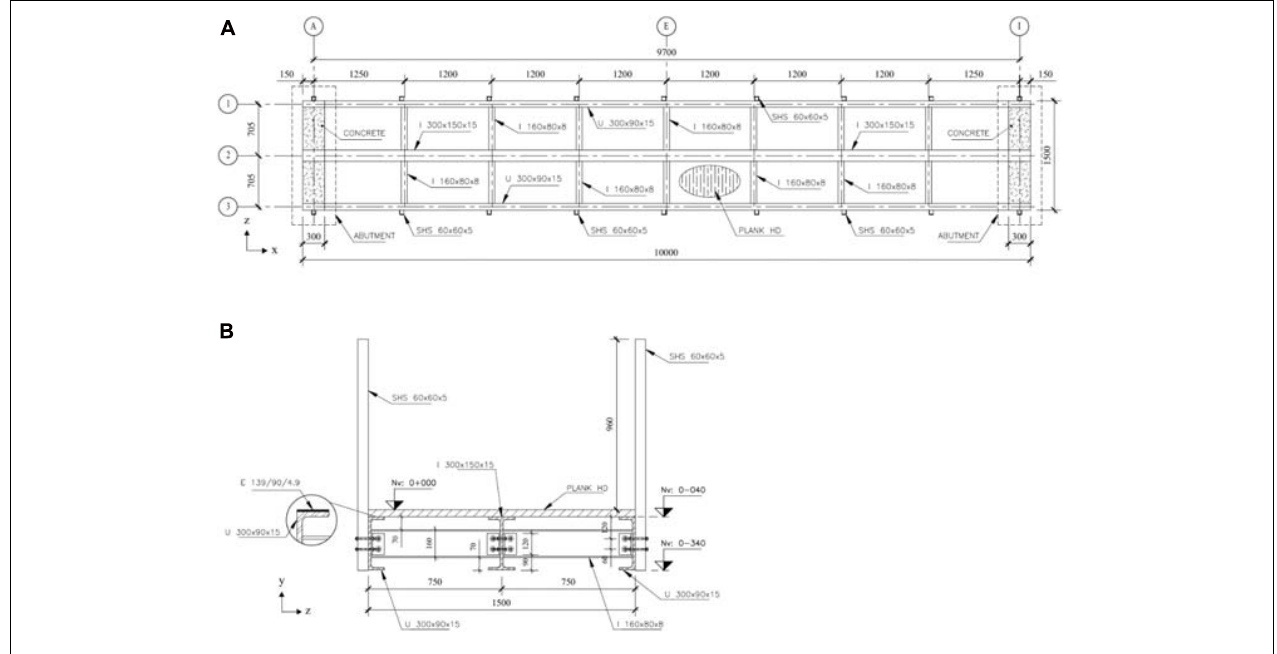
FIGURE 4 | FRP footbridge: (A) Plan view, and (B)